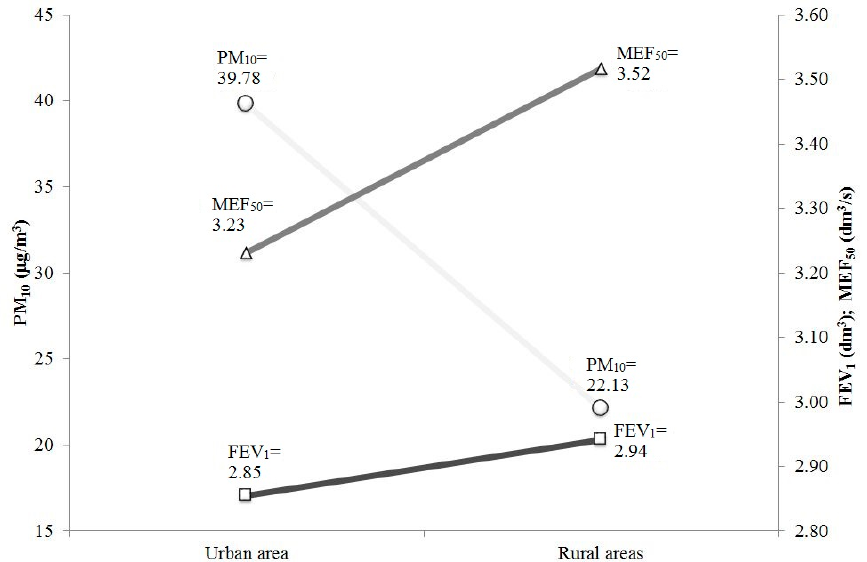
Figure 1. Mean values of FEV 1 (forced expiratory volume during the first second of expiration) and MEF 50 (maximal expiratory flow at 50% of vital flow capacity) in the city and control group and five-year average concentration of PM 10 in the air of urban and rural areas.